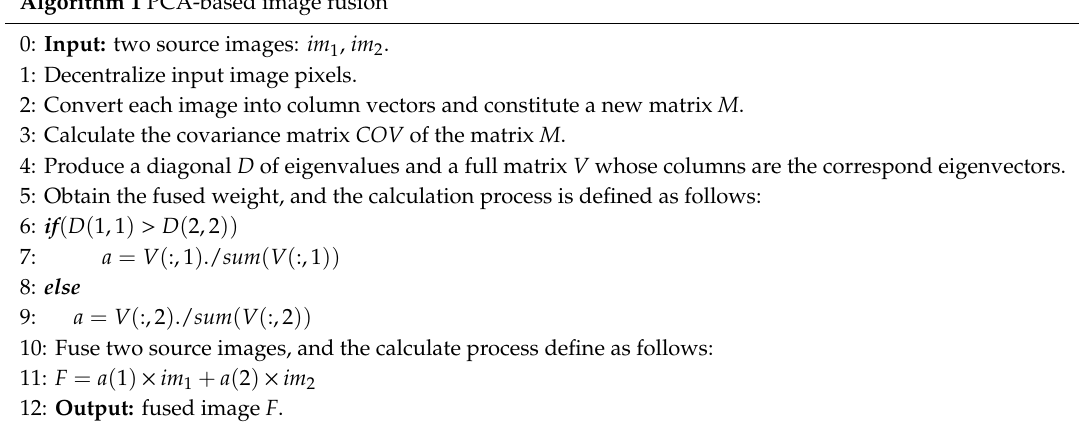
Algorithm 1 PCA-based image